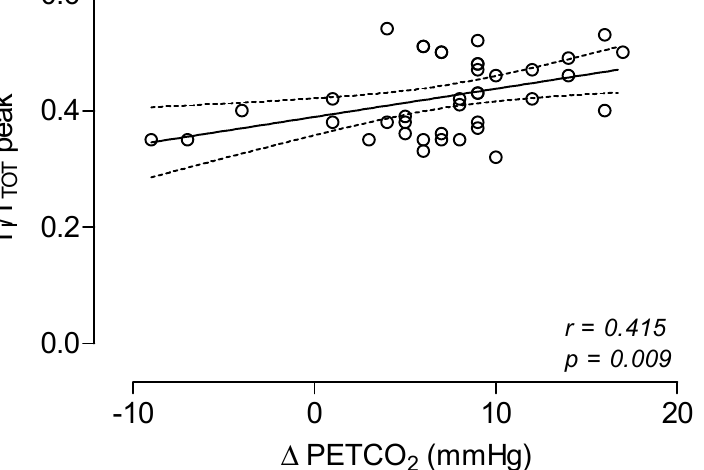
Figure 3. Relationship between T I /T TOT values at peak of exercise and Δ PETCO 2 values in 42 Long-COVID patients.